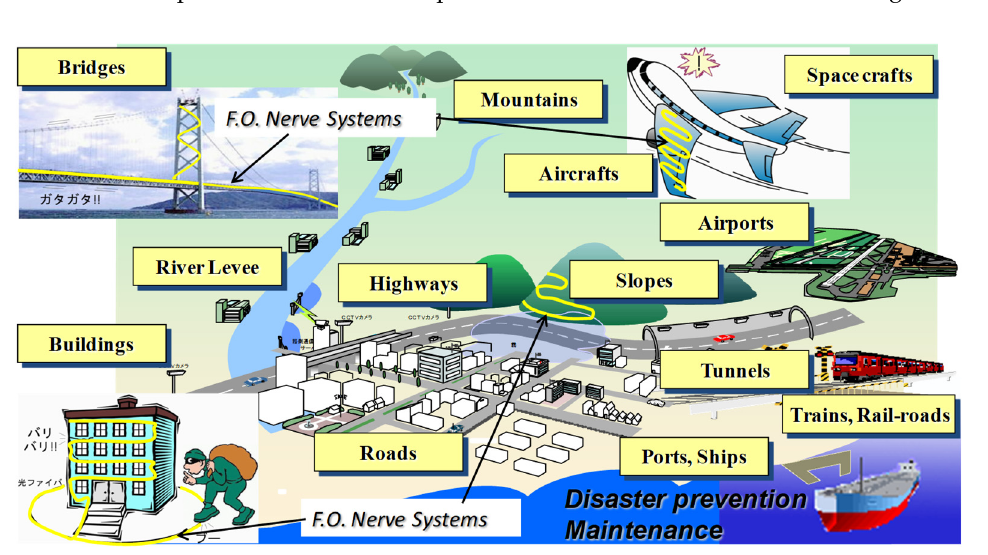
Figure 1. Fiber optic nerve systems to realize safety and security in the society.